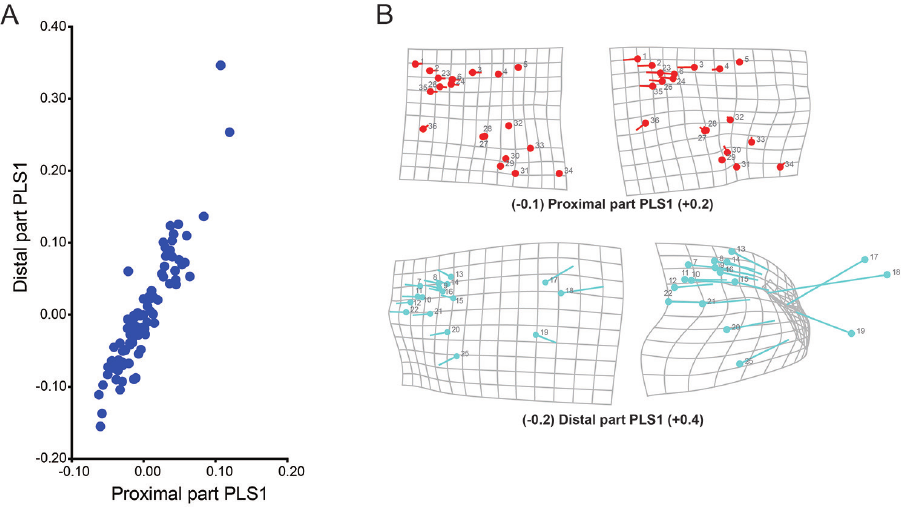
Figure 3. PLS analysis results. A Scatter plot of the PLS1 of two blocks B Shape changes associated with the first PLS axes of two blocks: each diagram shows the block change along the PLS1 in the positive or negative direction, corresponding to Figure